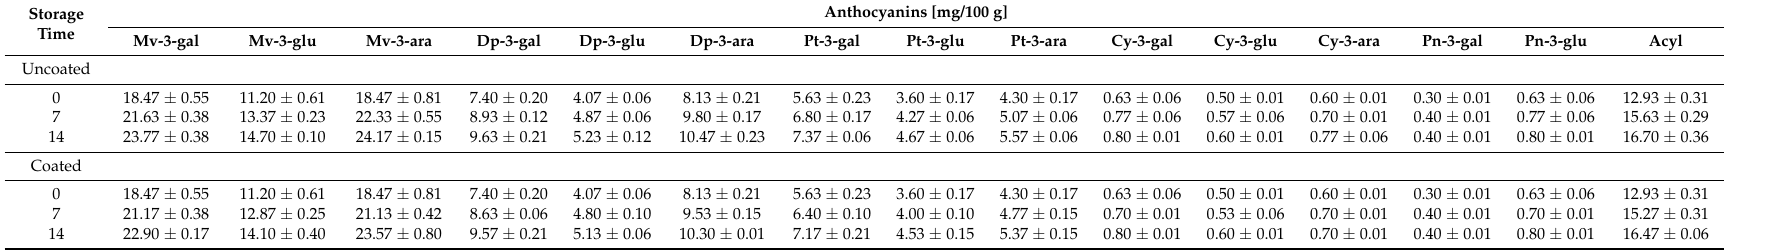
Table 6. Contents of anthocyanins in uncoated and coated blueberries fruit. Fruit were stored at 16 ◦ C for up to 14